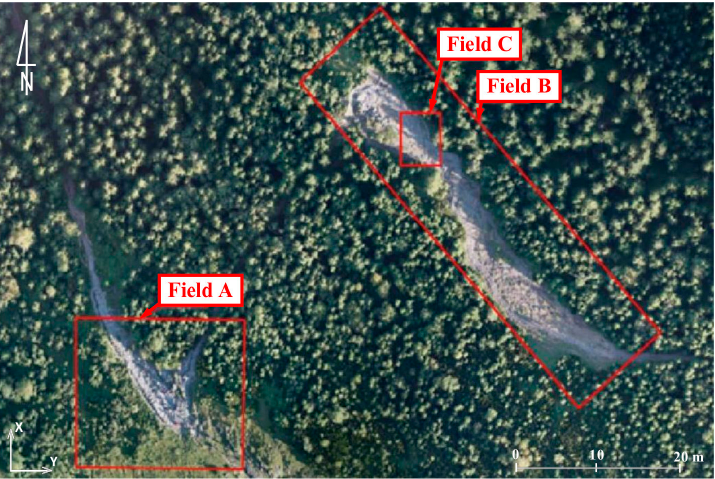
Figure 15. Test field: yellow trail in the area between Jaworzynka and Siod ł owa Per ć (source: authors’ own study).